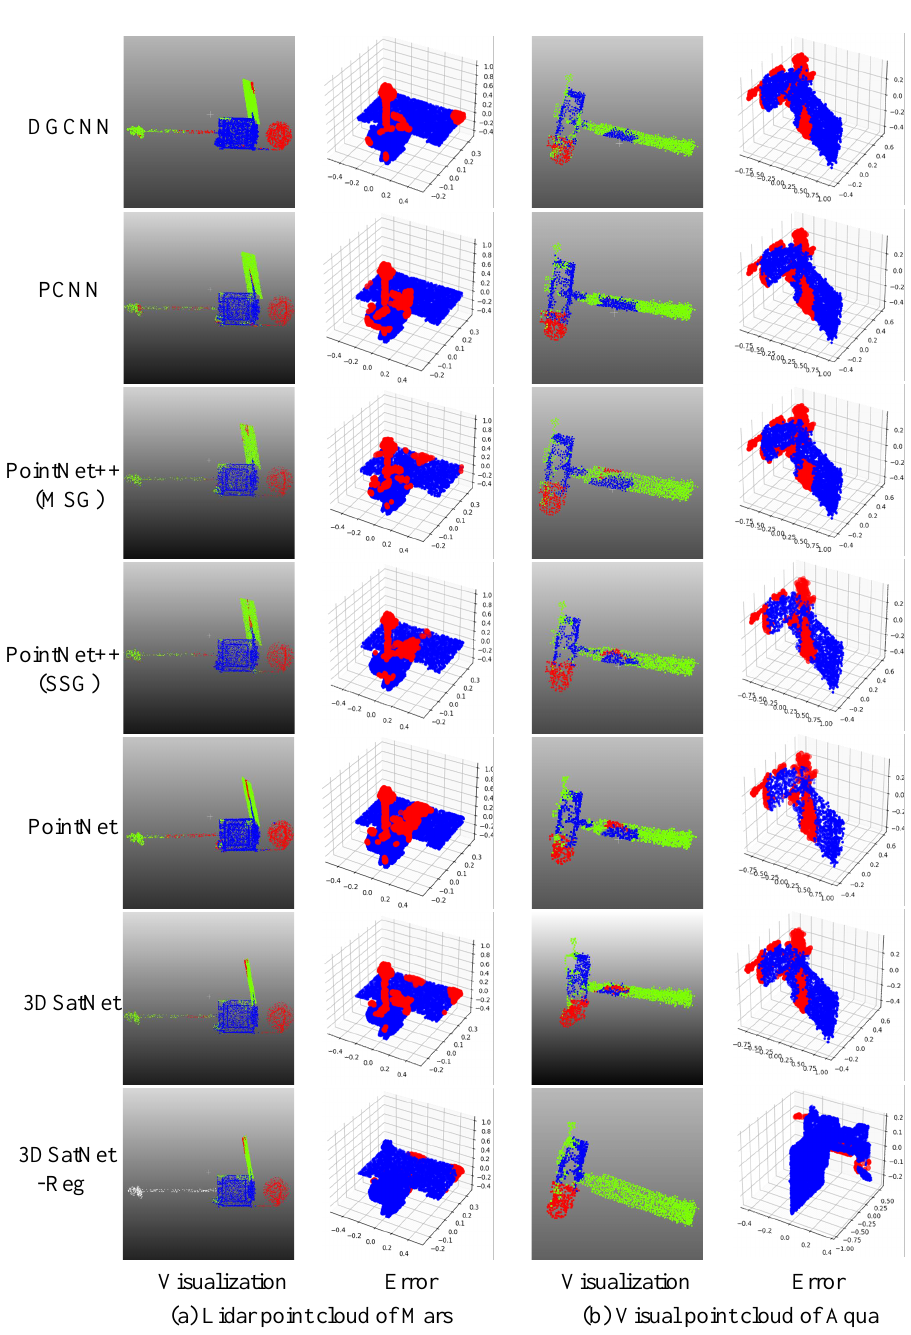
Figure A1. Spacecraft component segmentation results using special networks. (Blue: panel, Green: body, Red: Antenna. In error Figures: red points represent wrong segmented points, blue points represent points that are segmented